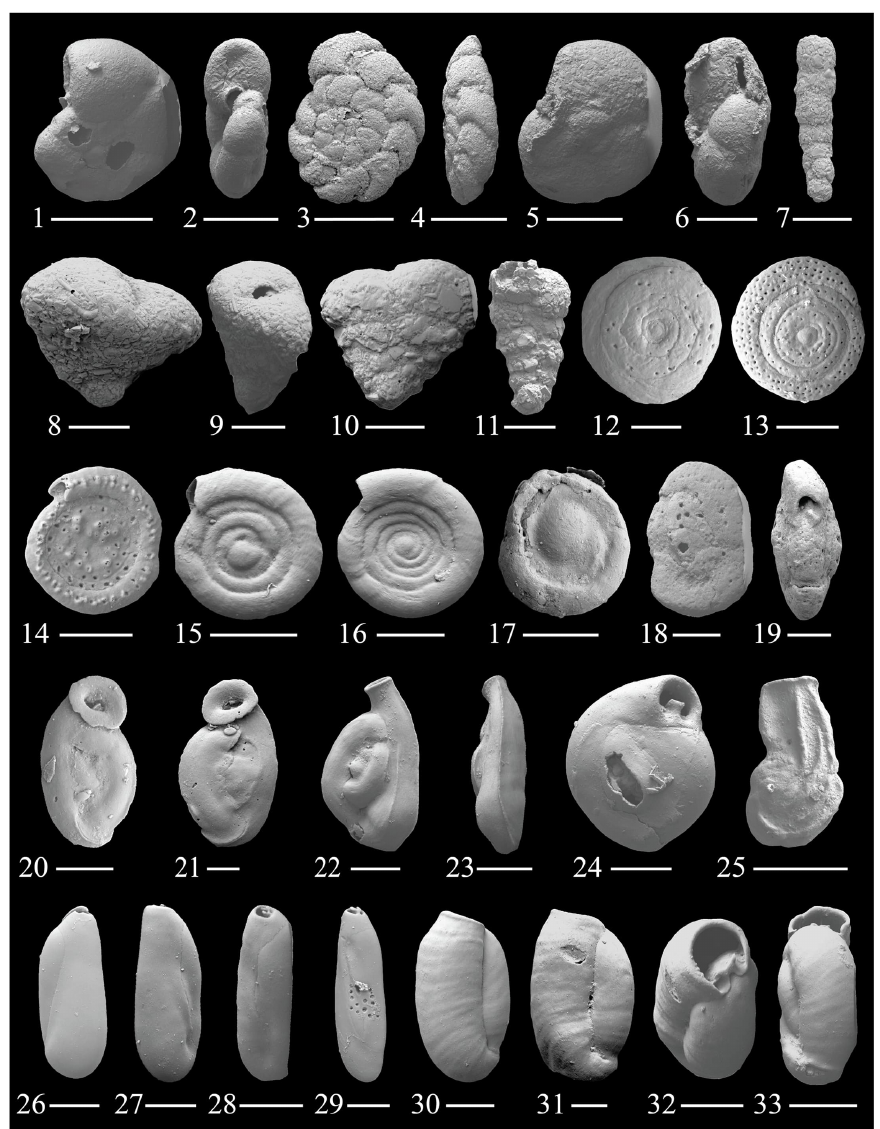
Figure 3. (1–2) Trochammina inflata (Montagu); (3–4) Rotaliammina trumbulli Seiglie; (5–6) Arenoparrella mexicana (Kornfeld); (7)